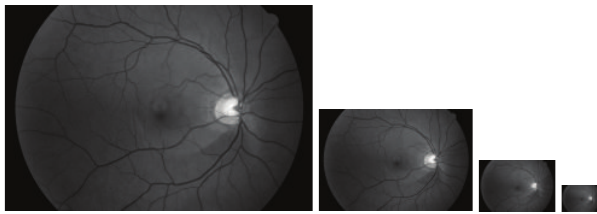
Figure 4: Example of a Gaussian resolution hierarchy using only the green channel of the input image and its three reduced resolution